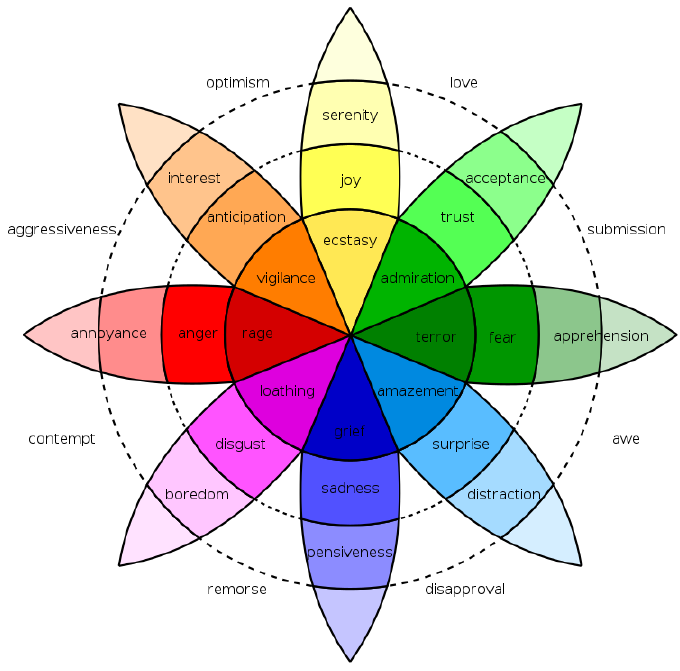
Figure 1. An extract of Plutchik’s wheel of